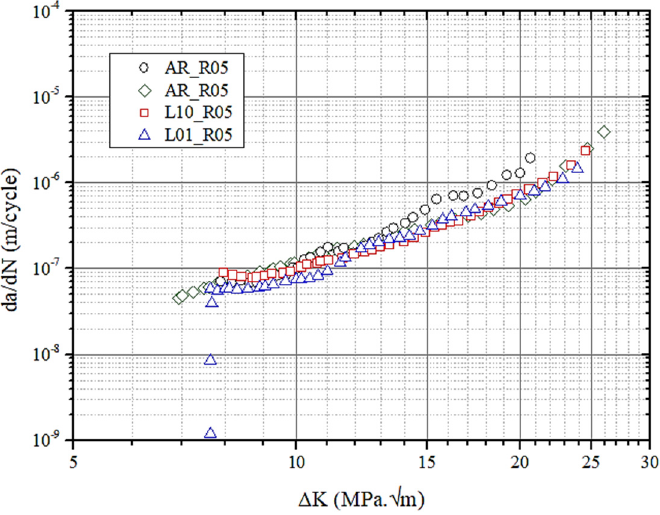
Figure 8. FCG test results: da/dN vs. Δ K plots for R = 0.5.